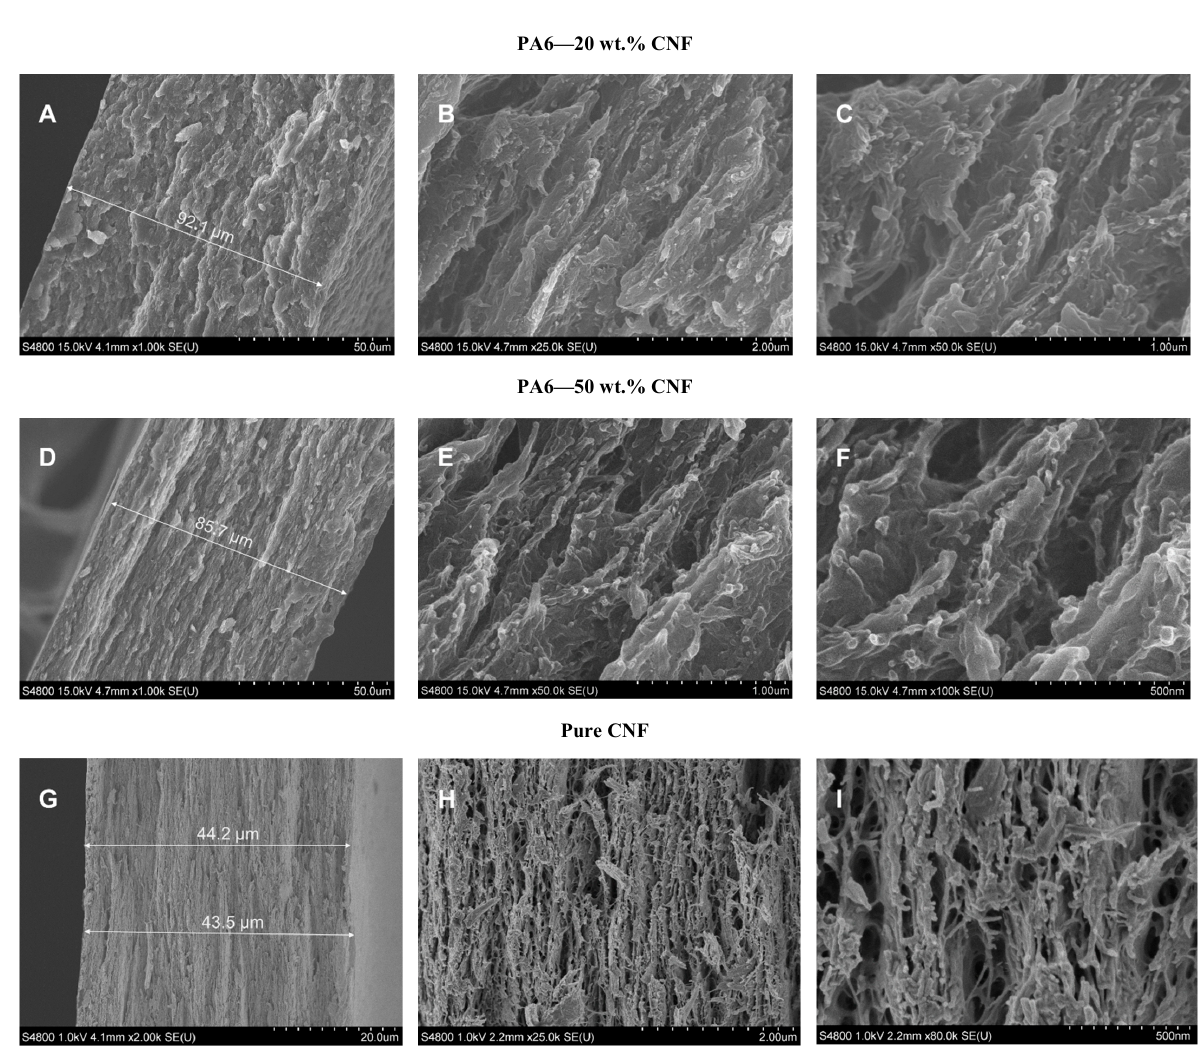
Figure 4. SEM micrographs for 20 wt.% (A – C ), 50 wt.% ( D – F ) PA6-CNF nanocomposites, and CNF nanopaper ( G – I ).